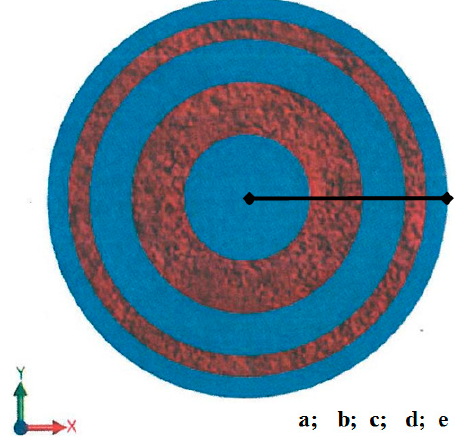
Figure 2. Five-phase spherical model.